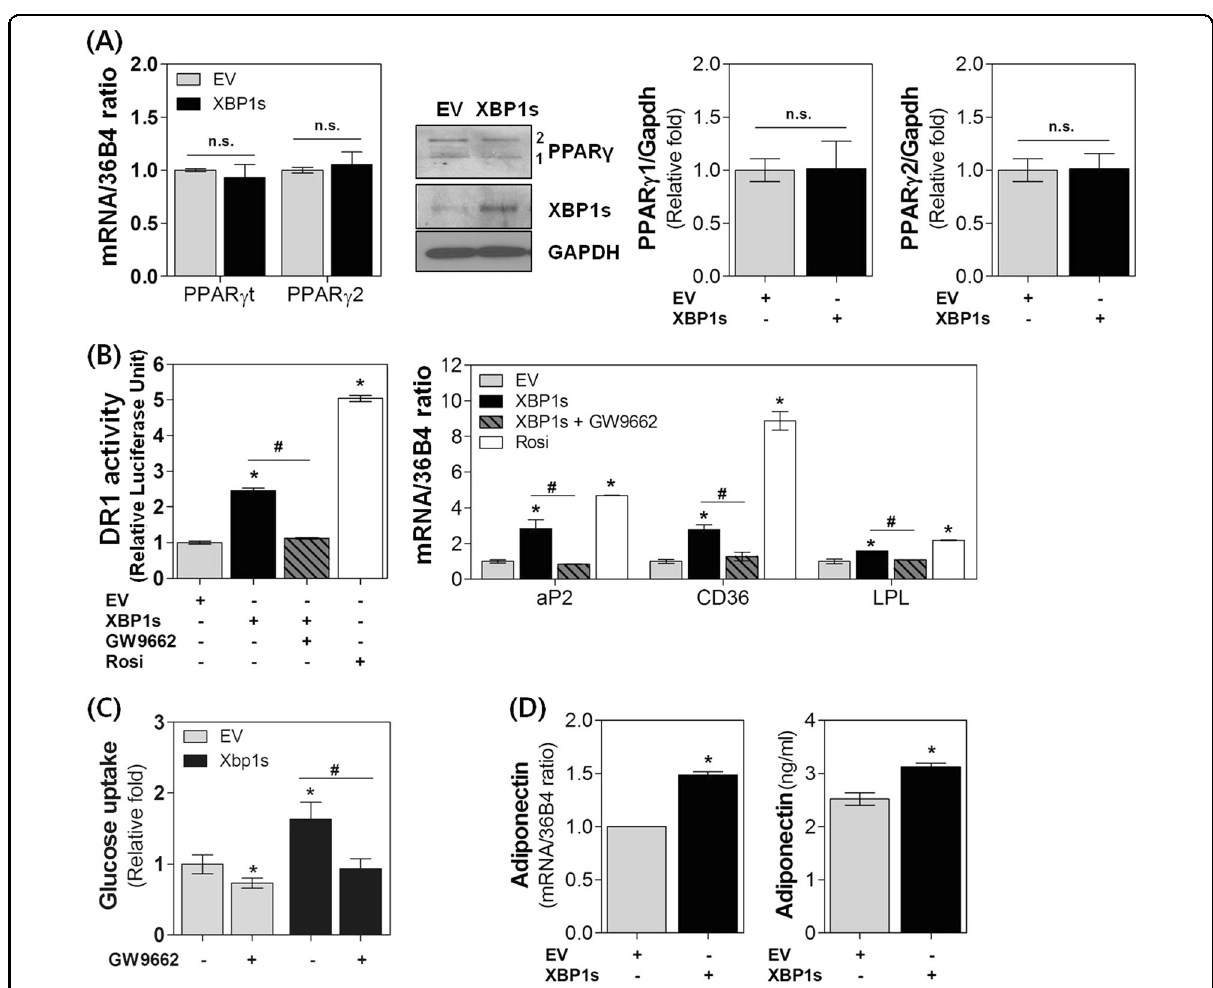
Fig. 2 XBP1s enhances insulin-mediated PPAR γ activation in adipocytes. 3T3-L1 adipocytes were transfected with control vector (EV) or pcDNA3.1-mXBP1s (XBP1s) and treated for 30 min with insulin (1 μ g ml − 1 ). a XBP1s and PPAR γ (1 and 2, or total) mRNA and protein levels were analyzed by real-time PCR and/or immunoblotting (left) and quanti fi ed with densitometry (right). b The effect of an XBP1s and PPAR γ activator (rosiglitazone, Rosi) or inhibitor (GW9662) on DR1 promoter activity (left) and the expression of the PPAR γ target genes aP2, CD36, and LPL (right) were examined by real-time PCR. c The effect of GW9662 on the XBP1s-mediated increase in glucose uptake was measured. d The effect of XBP1s on adiponectin mRNA and secreted protein levels were determined using real-time PCR and ELISA, respectively. Values are presented as the means ± SEM of three independent experiments. * P < 0.05 compared to EV. # P < 0.05 compared to XBP1s. n.s. not signi fi